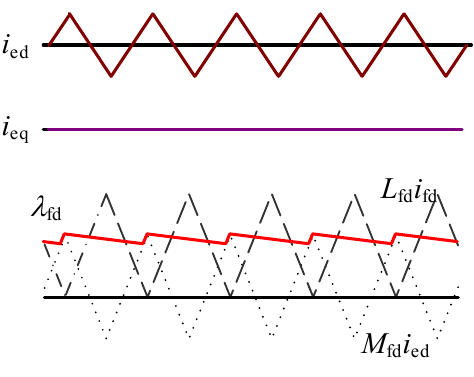
Figure 3. Waveforms of dq currents and field flux